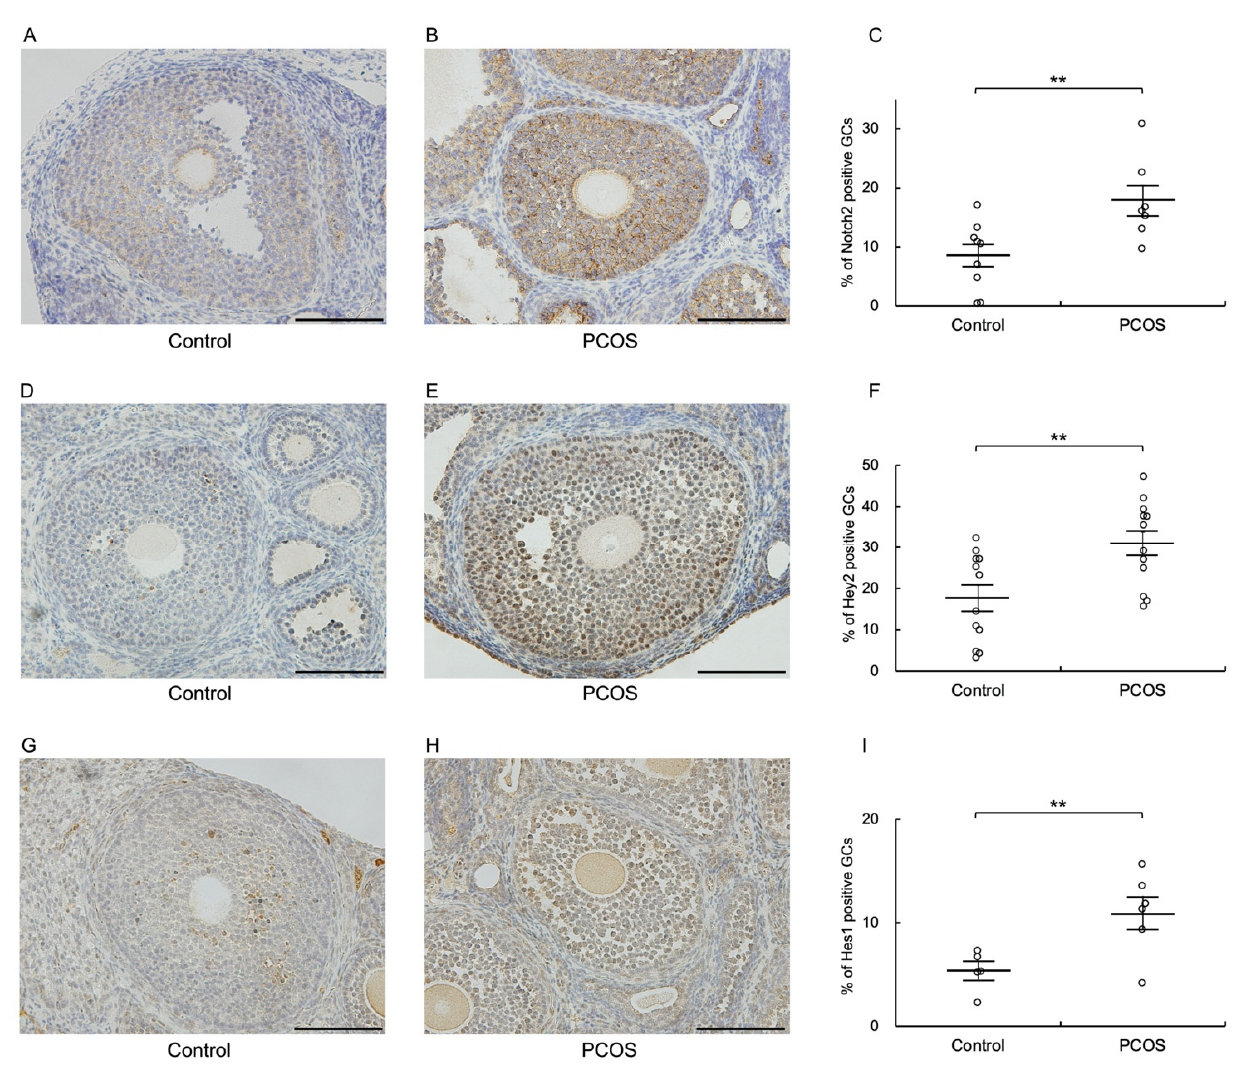
Figure 2. Notch2, Hey2, and Hes1 are upregulated in granulosa cells of PCOS model mice. Immuno- histochemical analysis was performed on antral follicles of ovaries from control (n = 7) and PCOS (n = 7) mice. Cross-sections of ovaries were stained with an ( A – C ) anti-Notch2, ( D – F ) anti-Hey2, or ( G – I ) anti-Hes1 antibody and counterstained with hematoxylin. ( C , F , I ) Quantitative analysis of immunohistochemical staining. The scale bars indicate 100 µm. ** p < 0.01 compared with control. GCs, granulosa cells.